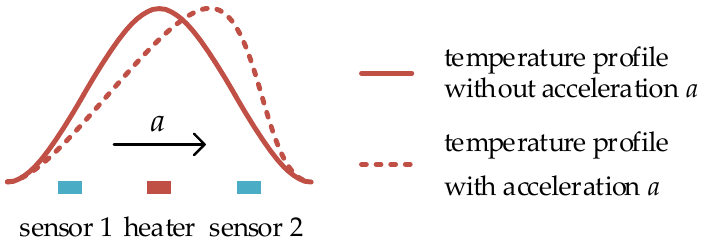
Figure 1. Operation principle of micromachined thermal accelerometer.